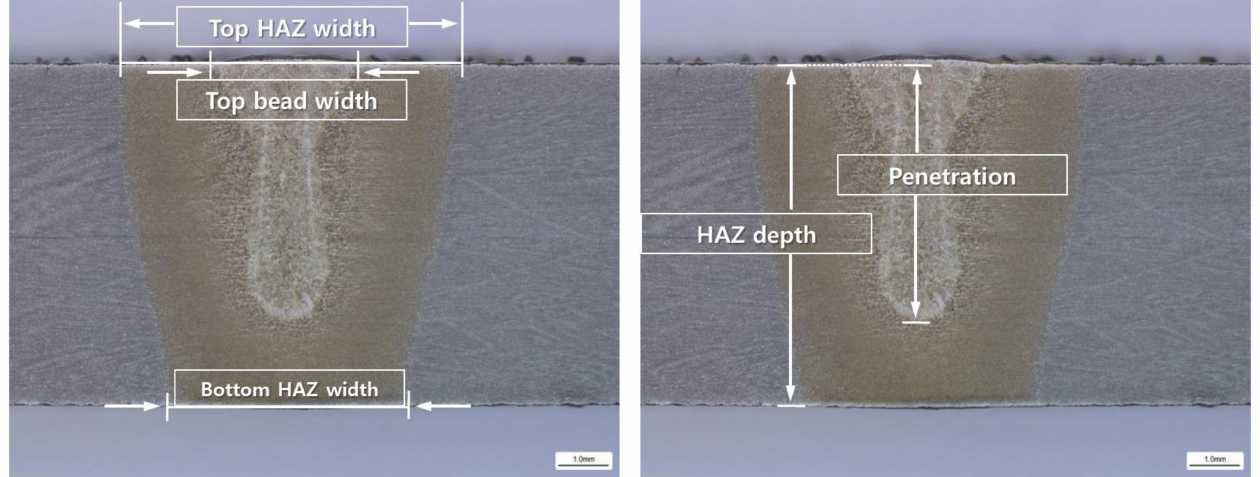
Figure 3. Cross-section measurement location and definition. The cross-sectional measurement positions of the melted zone and the heat-affected zone are as follows: through the micro-section